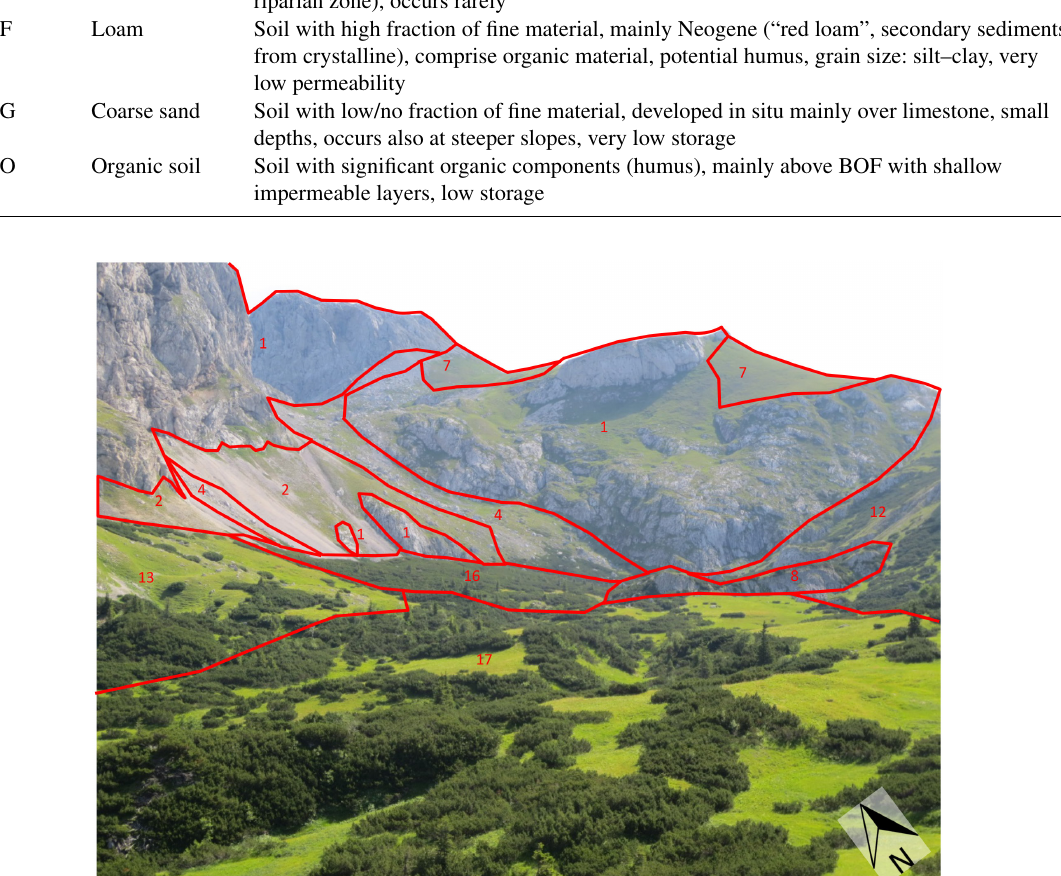
Figure 2. Example of delineation of response units based on Table 1. For an explanation of units see Table 2. To illustrate the scale, the diameter of polygon no. 16 from left to right is approximately